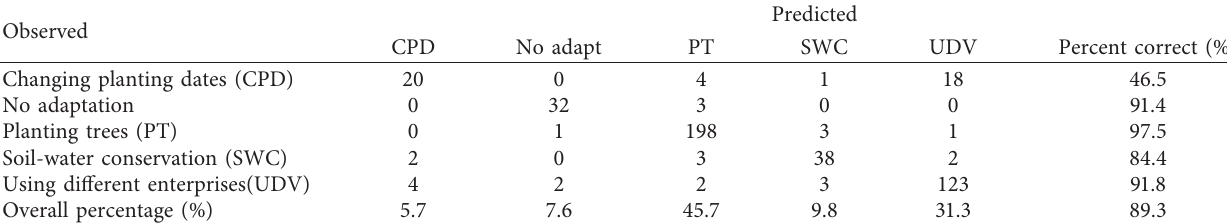
Table 1: Classification Table. Assumption of independent irrelevant alternative (IIA).